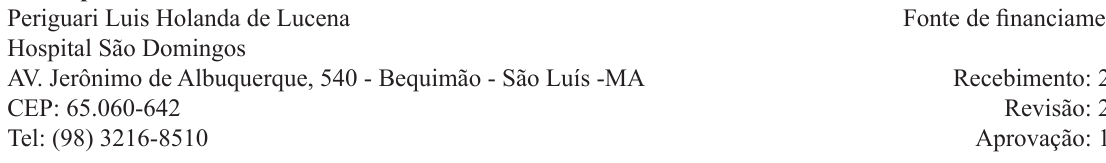
Figuras coloridas disponíveis em